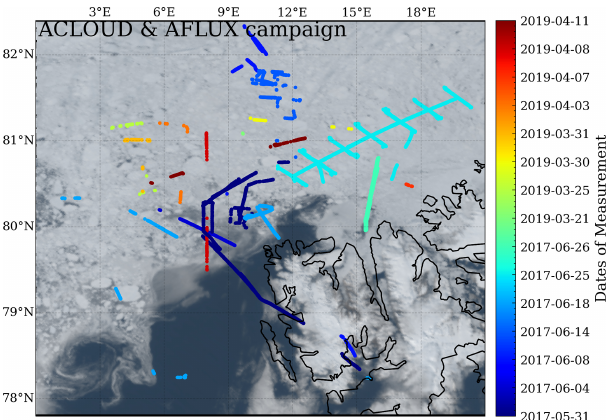
Figure 3. ACLOUD and AFLUX transits of selected flight seg- ments from Polar 5 and Polar 6. The true-color composite from 25 June 2017 is shown in the background. MODIS channels 645, 555, and 469nm are used as (R, G, B) bands for the true-color RGB. The dates of flight operations are denoted by hues defined by the color bar on the